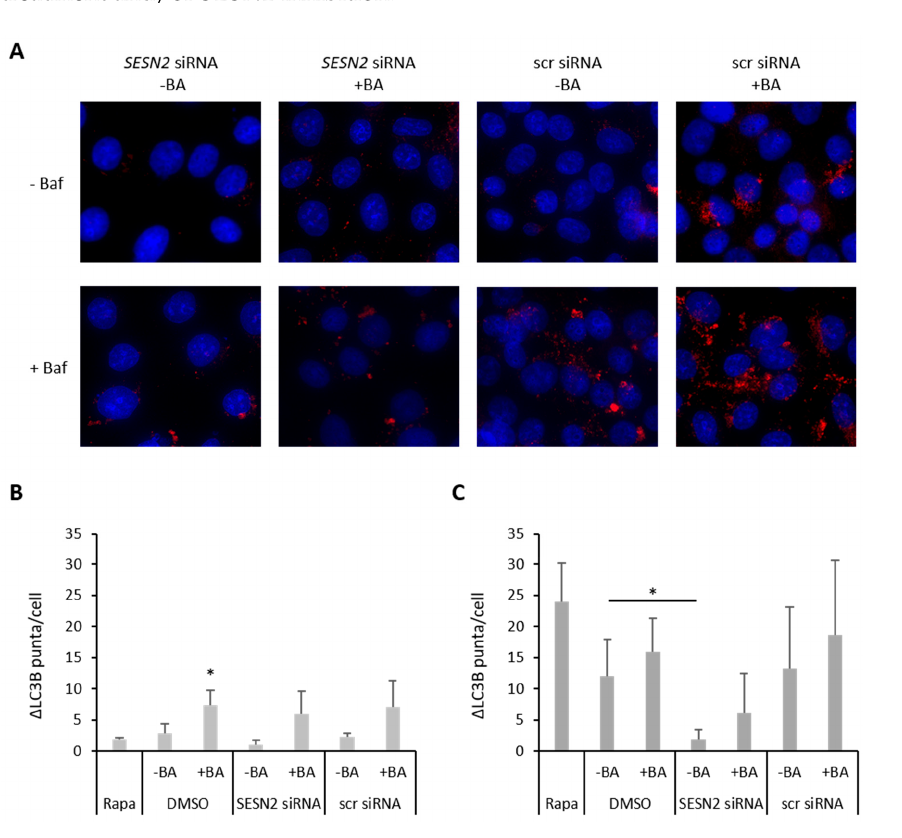
Figure 6. Bafilomycin-Clamp-Assay. MDA-MB-231 cells were transfected with siRNA against SESN2 and treated with BA under hypoxic conditions (0.1% O 2 ) with and without BafA1. LC3B puncta per cell were counted out of at least 100 cells. ( A ) Representative immunofluorescence staining of LC3B (red) and cell nuclei (blue: DAPI). ( B ) LC3B puncta per cell after siRNA and BA treat ‐ ment without BAf1A. ( C ) Autophagic flux ( Δ LC3B puncta) of MDA ‐ MB ‐ 231 cells under hypoxic conditions. Data represent mean values (+SD) of three independent experiments. All data were re ‐ ferred to scr siRNA without BA treatment. Significant p values are highlighted with asterisks (* p ≤ 0.05).